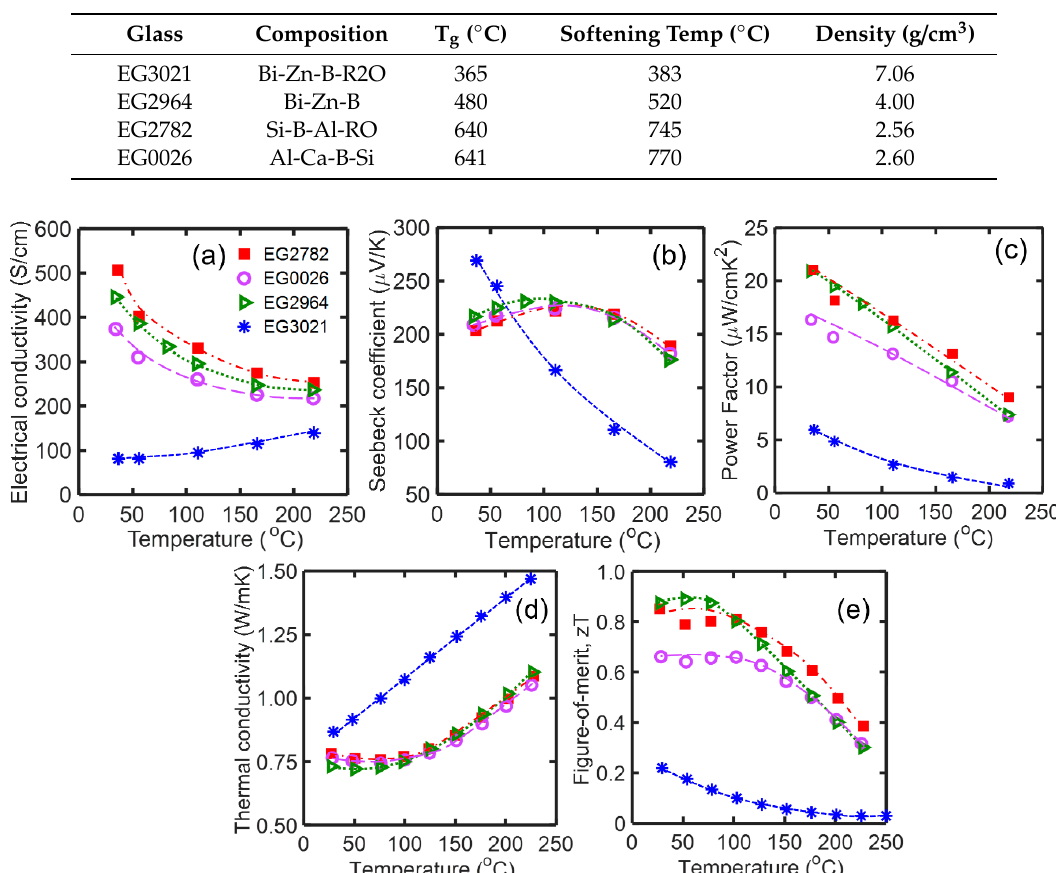
Figure 2. Comparison of ( a ) electrical conductivity, ( b ) Seebeck coefficient, ( c ) thermoelectric (TE) power factor (PF), ( d ) thermal conductivity, and ( e ) TE figure-of-merit (zT) of (Bi 0.25 Sb 0.75 ) 2 Te 3 alloys including 5 wt% EG3021, EG2964, EG2782, and EG0026 glass inclusions.